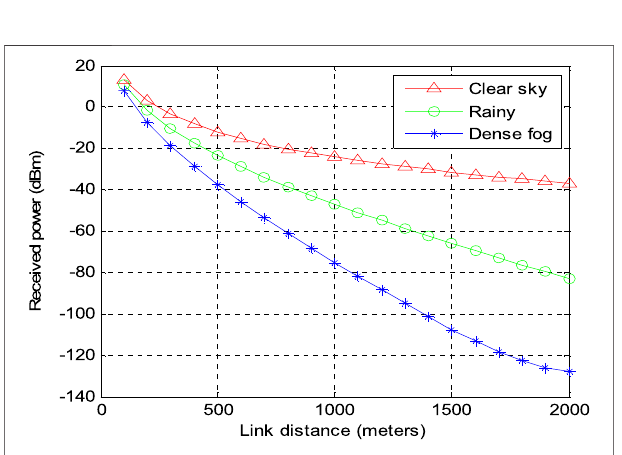
FIGURE 8 | Relation between received signal power and link distance.